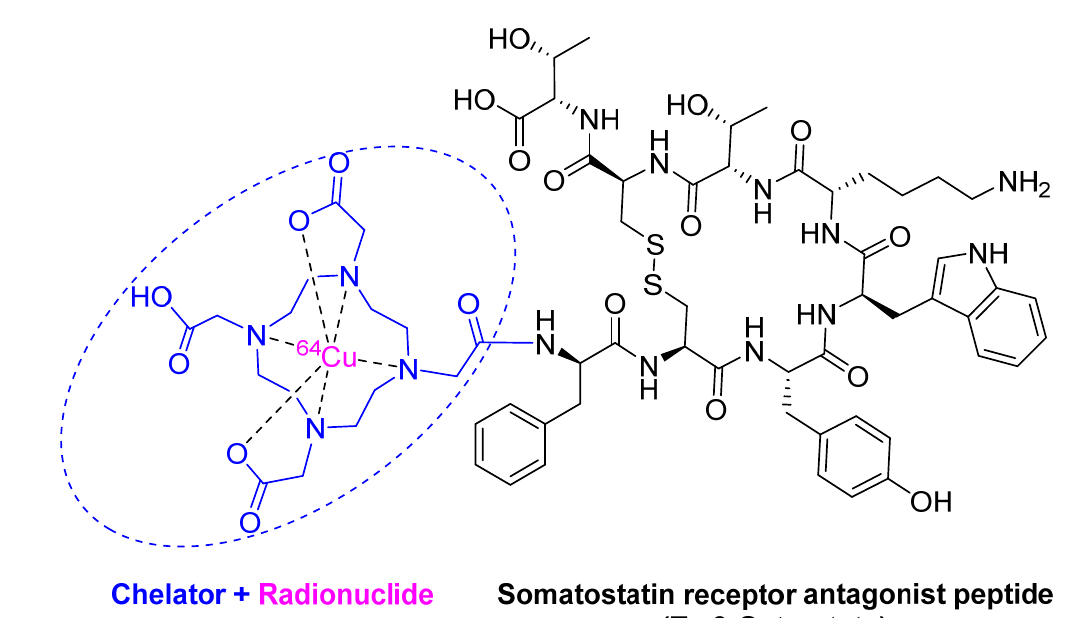
Figure 5. Chemical structure of 64 Cu ‐ DOTATATE (Detectnet TM ).